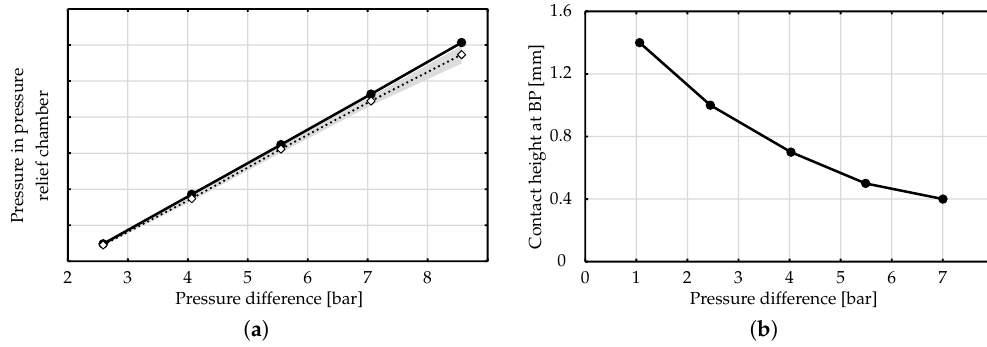
Figure 5. ( a ): Pressures in the pressure relief chamber as a function of the inlet pressure, experiment ( ), CFD ( ); ( b ): Contact height at the back plate h BP depending on the pressure